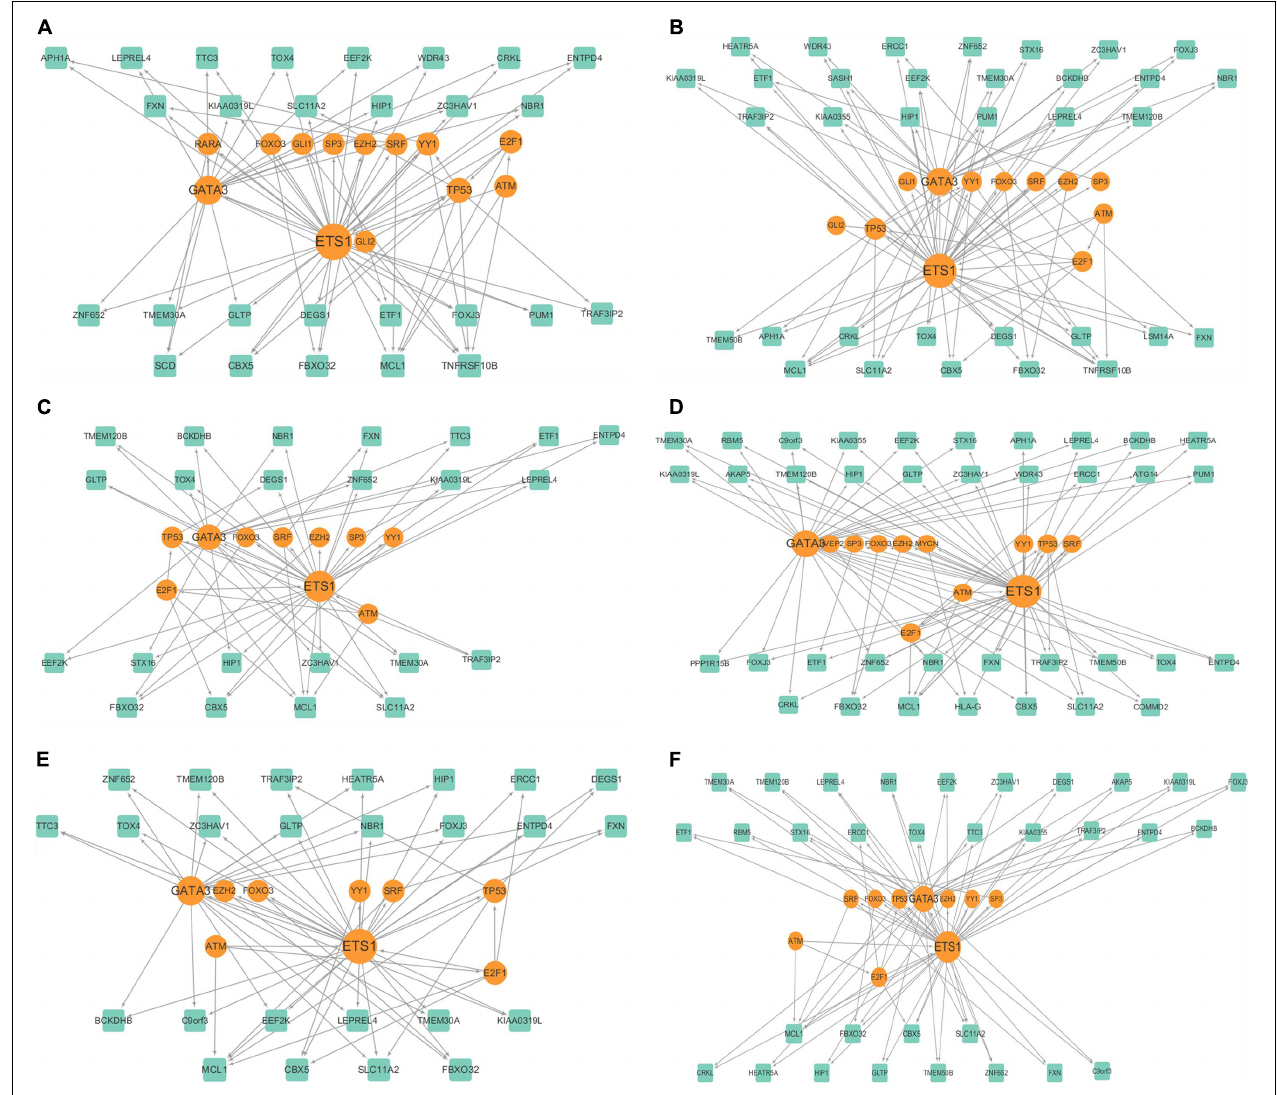
FIGURE 4 | Cluster specific gene regulatory networks of (A–F) 6